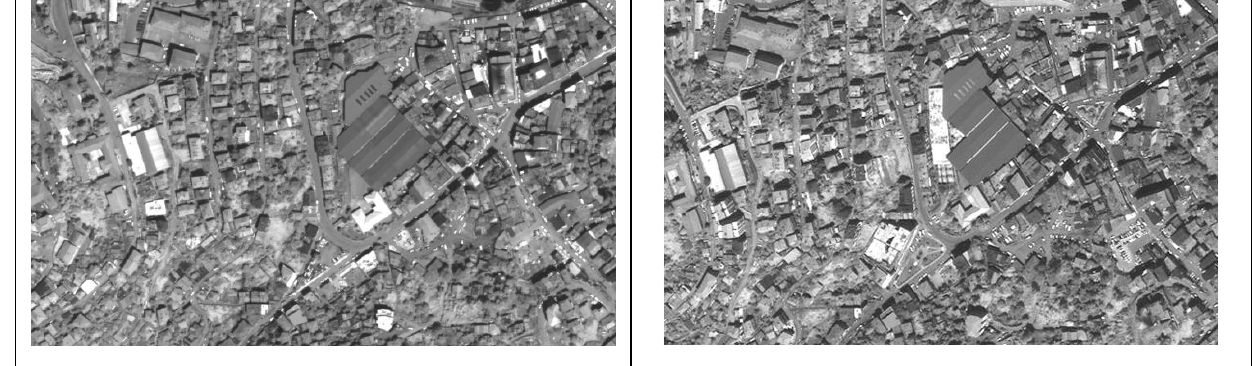
Figure 3. Panchromatic Quickbird image (left) , panchromatic IKONOS image – same area (right)